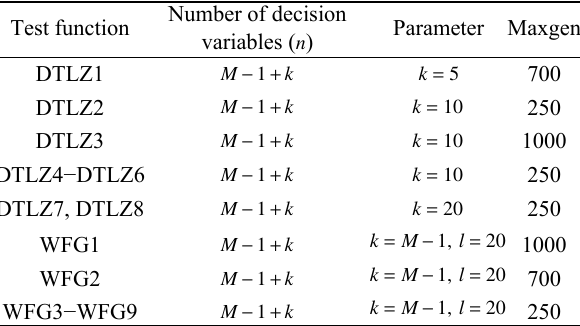
Table 2 Parameter settings for the test functions. Test